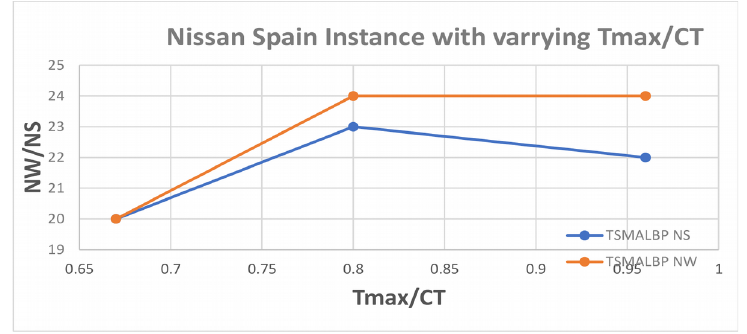
Figure 9. The number of stations and number of workers drawn against